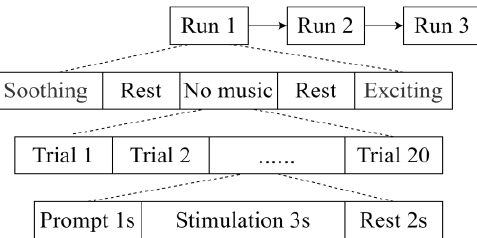
Figure 2. Timing of the main experimental sequence. For each participant, the experimental task was repeated three